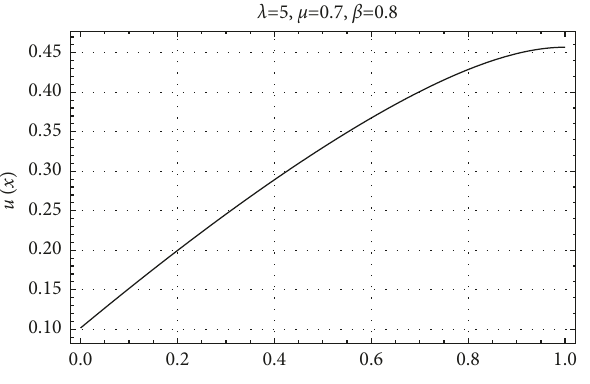
Figure 1: Graph of numerical outputs for λ � 5 , μ � 0 . 7, and β � 0 . 8. λ =5, μ =0.05, β =0.53